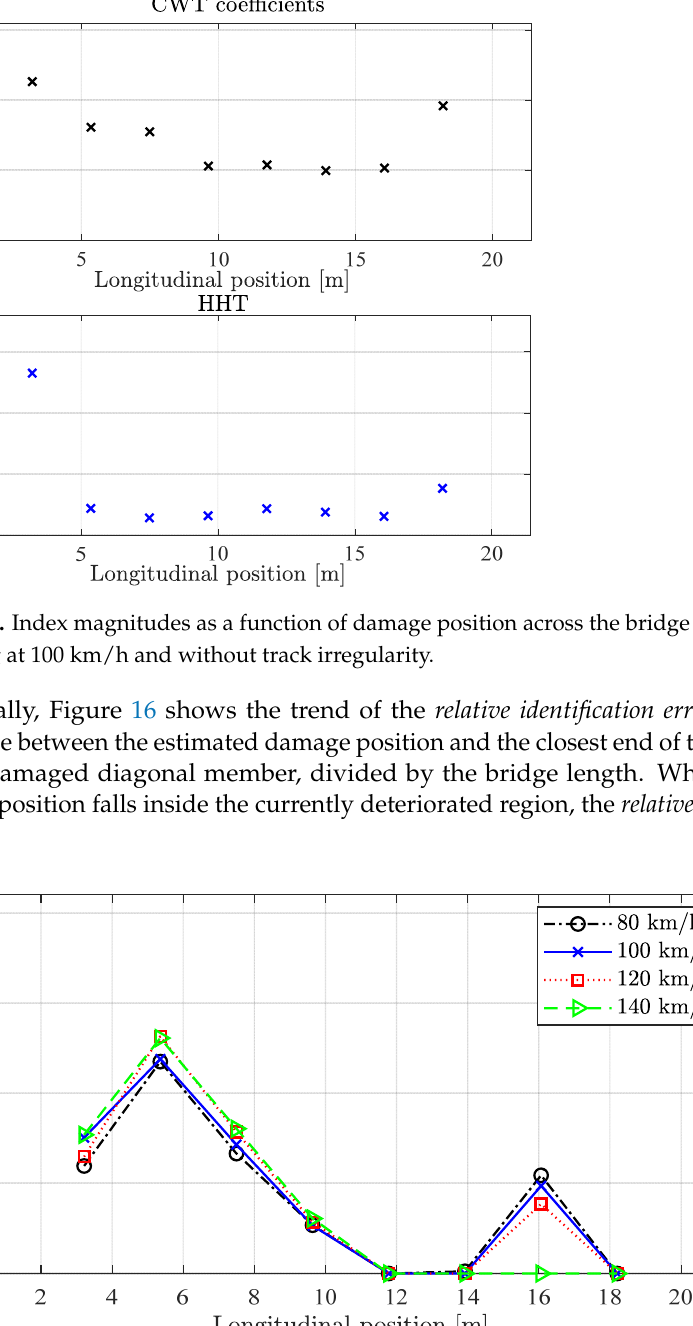
Figure 16. Relative identification error as a function of travelling speed and damage position, with the CSA train and a slight change of irregularity profile.